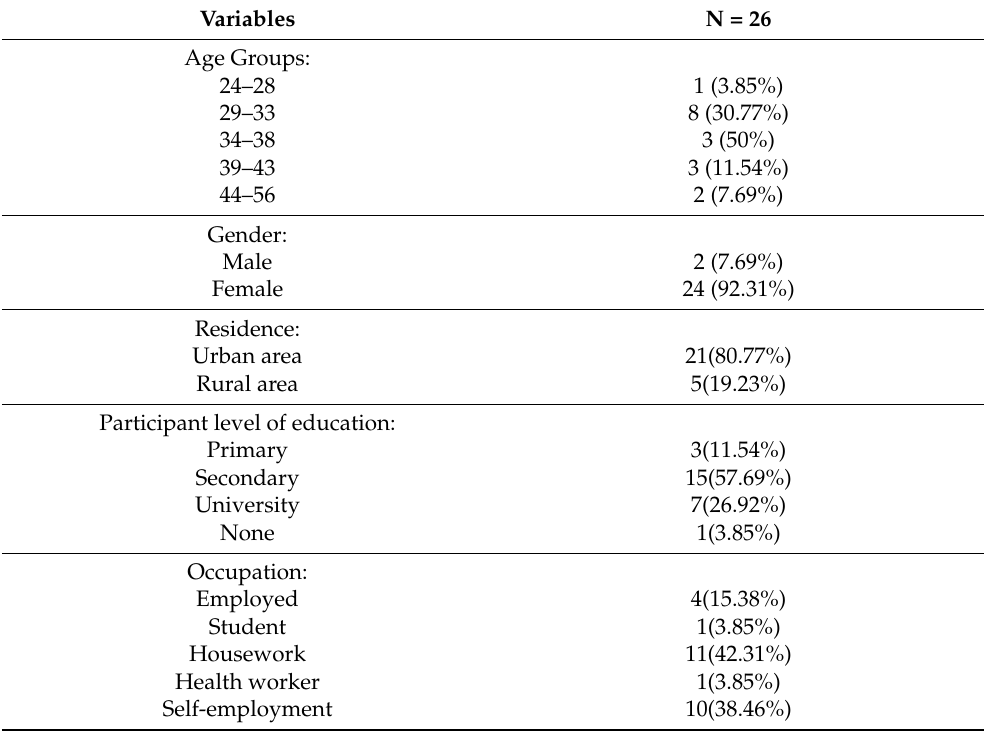
Table 1. Demographic characteristics of the parents/caregivers of children with SCD in Kinshasa,